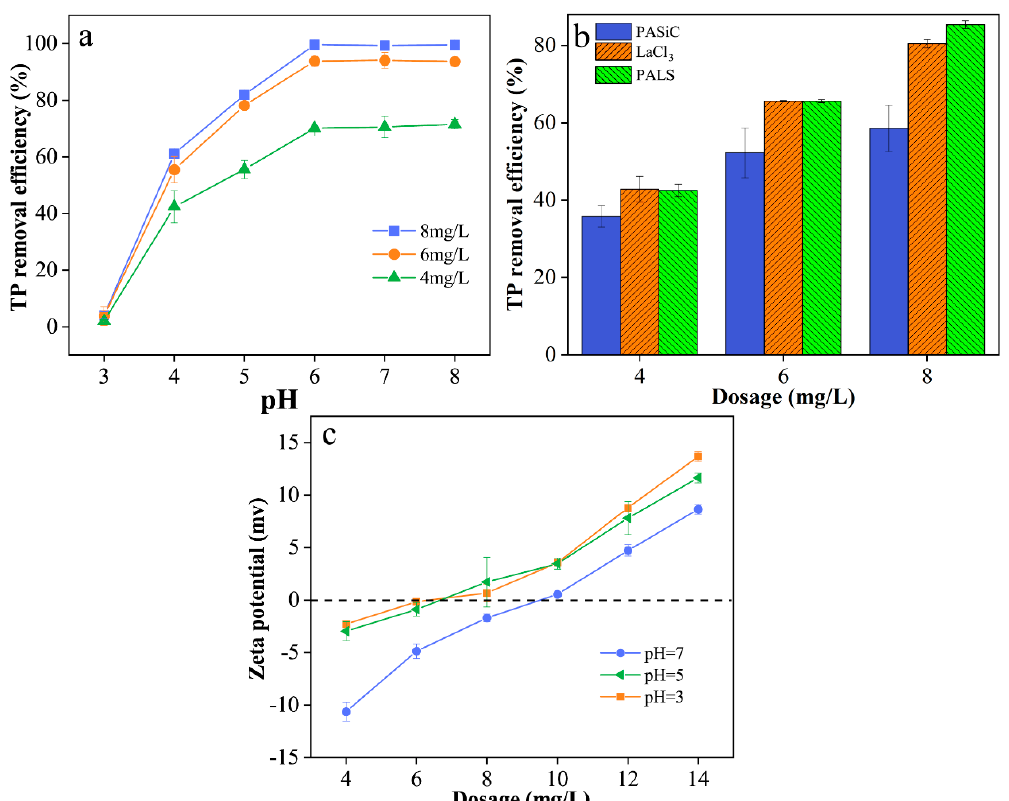
Figure 7. TP removal efficiency at pH = 3–8 by PALS with initial phosphate concentration = 2 mg L − 1 ( a ); TP removal efficiency by PASiC, PALS, and LaCl 3 at dosages of 4–8 mg L − 1 with initial phosphate concentration = 5 mg L − 1 and pH = 7.8 ( b ); zeta potential of flocs at dosages of 4–14 mg L − 1 with PALS ( c ).